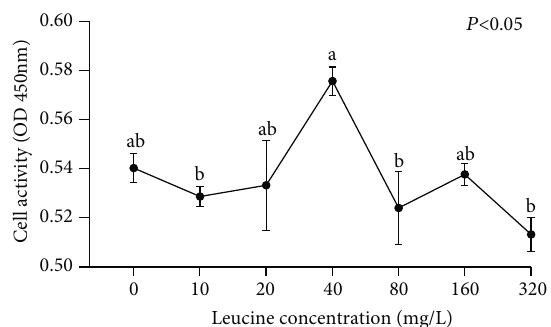
Figure 1: The activity of blunt snout bream muscle cells cultured in the seven medium of leucine levels. Values are represented as mean ± SEM ( n = 4 ) by vertical bars. Mean values with di ff erent letters indicate signi fi cantly di ff erent ( P < 0 : 05